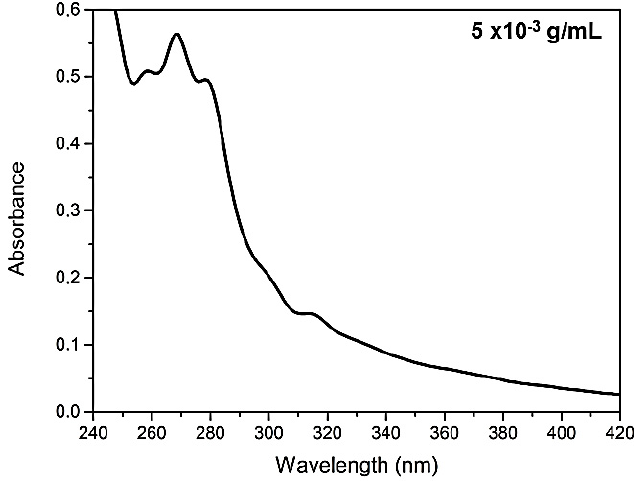
Figure 1. Molecular absorption spectra of Caryocar brasiliense oil, obtained at 200–600 nm.